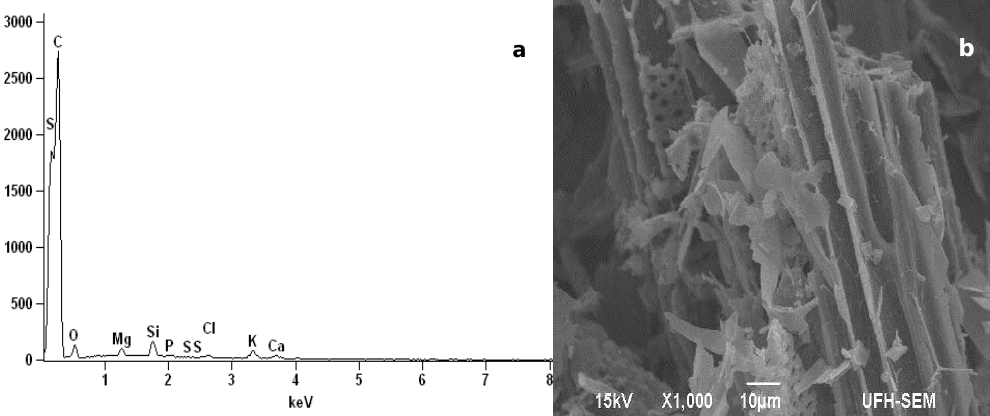
Figure 1. Maize residue biochar images from ( a ) Scanning electron micrographs (SEM) and ( b ) energy- dispersive spectroscopy (EDX) showing the chemical composition intensity. Kev: kilo-electron volt